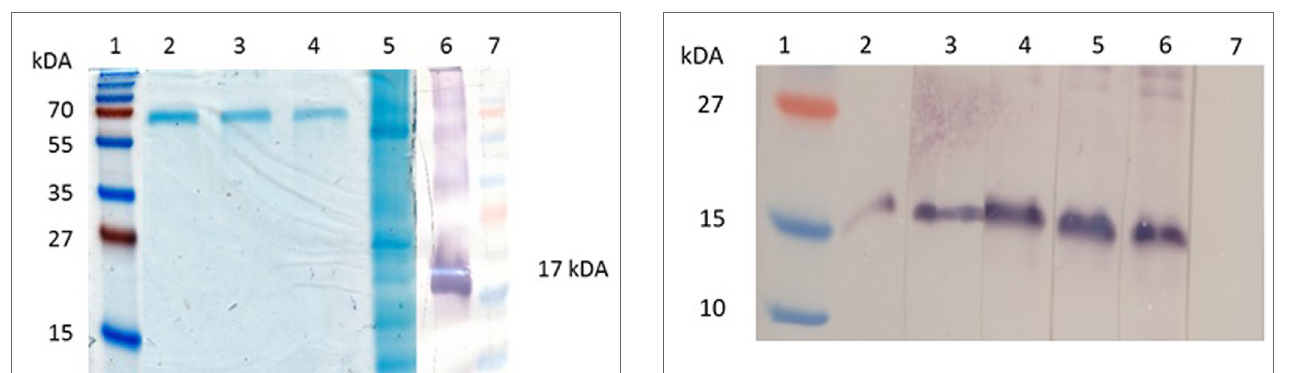
FigUre 4 | Detection of Zera ® M2e-specific antibodies in plant- produced Zera ® M2e immunized mice sera . Insect cell-produced Zera ® M2e protein bodies (PBs) were loaded in each lane, and then the membrane was cut into strips and probed with individual mouse serum. Lane 1 contains PageRuler ™ Prestained protein ladder (Fermentas), lane 2 contains the positive control, i.e., Zera ® M2e PB detected with a commercial M2 primary antibody (1:5000) (ab65086, Abcam, Cambridge, UK). Lane 3–6 were detected with mice sera from mice immunized with plant-produced